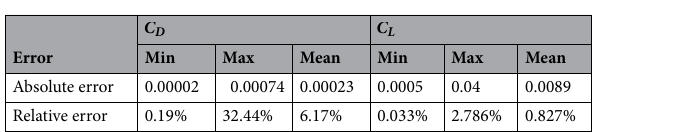
Table 4. Summary of absolute and relative error of C D and C L coefficients predicted by the CNN.